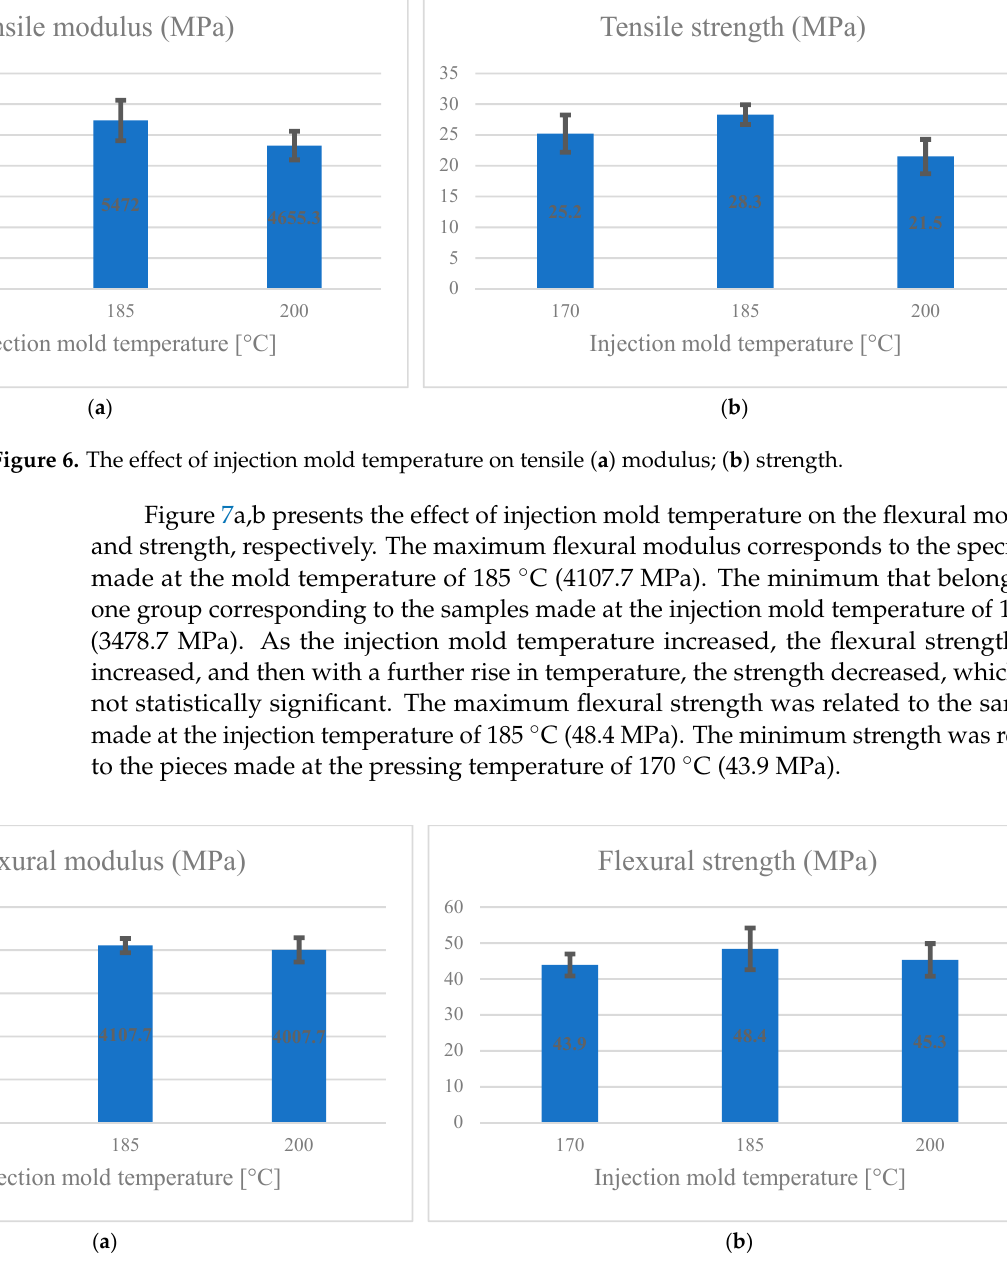
Figure 7. The effect of injection mold temperature on flexural ( a ) modulus; ( b ) strength. Figure 8 presents the effect of injection mold temperature on impact energy. The lowest value of impact energy was obtained at the injection mold temperature of 200 °C. The impact energy was highest at a mold temperature of 185 °C. As the injection mold temperature increased from 170 to 185 ◦ C, the tensile strength and modulus, flexural strength and modulus, and impact energy increased by 10.1, 11.4, 10, 18.1, and 26%, respectively. Furthermore, with an increment to 200 ◦ C, the tensile strength and modulus, and impact energy decreased by 19.5, 5.5, and 4.2%, respectively. On the other hand, the flexural strength and modulus increased by 3 and 5.9%. physical properties by mathematical expressions of polymer-based composites. There